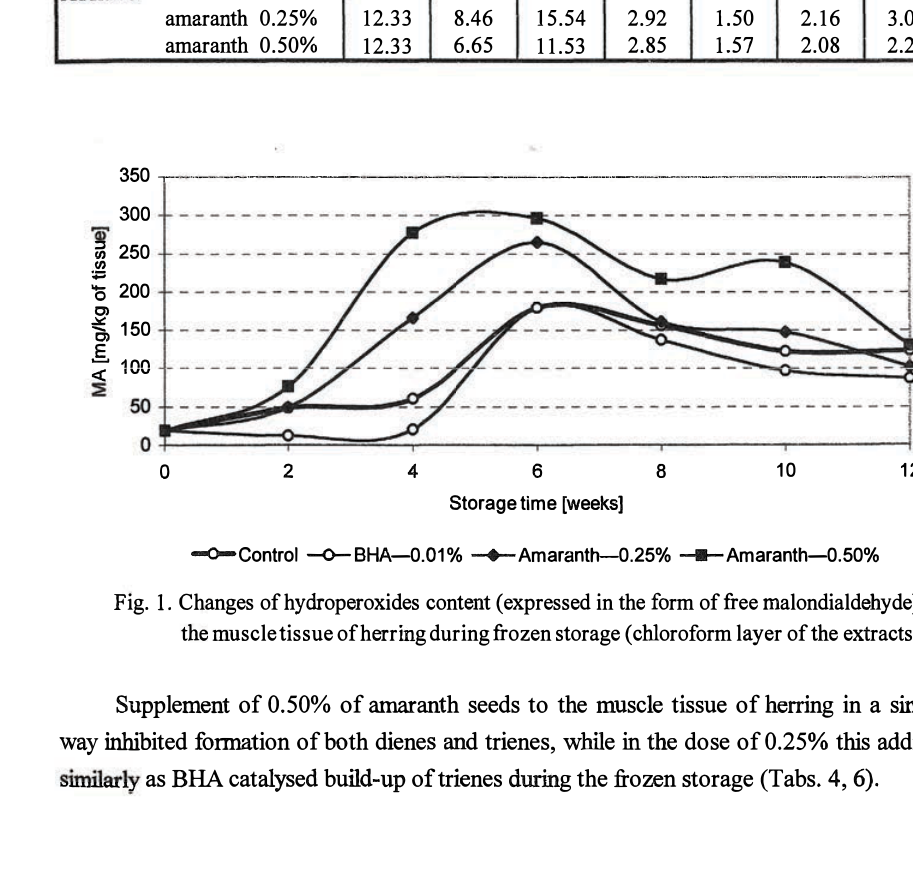
Changes of the absorption coefficient value for conjugated fatty acids ( dienes) of herring muscle tissue lipids during frozen storage Sample